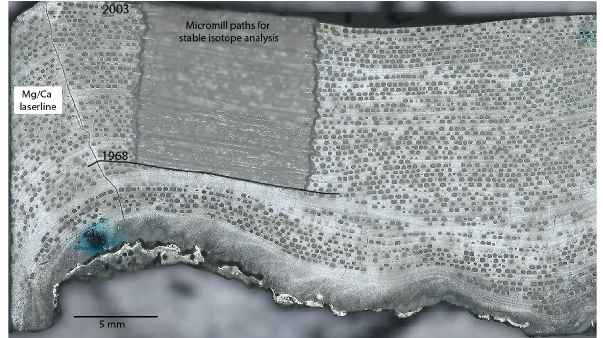
Figure 2. 606 Fig. 2. Photomosaic of polished section of specimen AM4-1 with laser transect and micromill path. Micromilling path ran parallel to growth increments. Clear annual growth increments from 2003 to 1968 were used in conjunction with Mg/Ca measured by laser ablation inductively coupled plasma mass spectrometry to develop a robust growth chronology for this specimen. Samples for sta- ble isotope analysis were micromilled directly adjacent to the laser